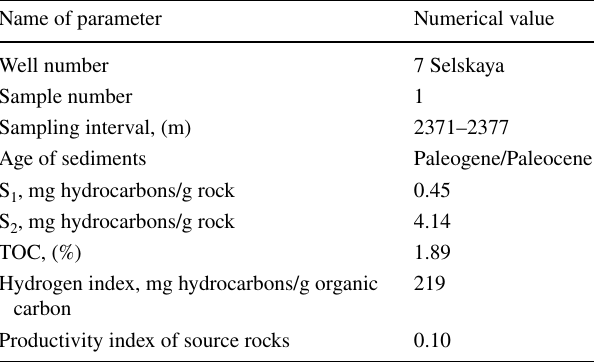
Fig. 5 Oil shows at the casing head of Well # 7 Selskaya Table 6 The results of the pyrolysis of core sample from Paleocene sediments